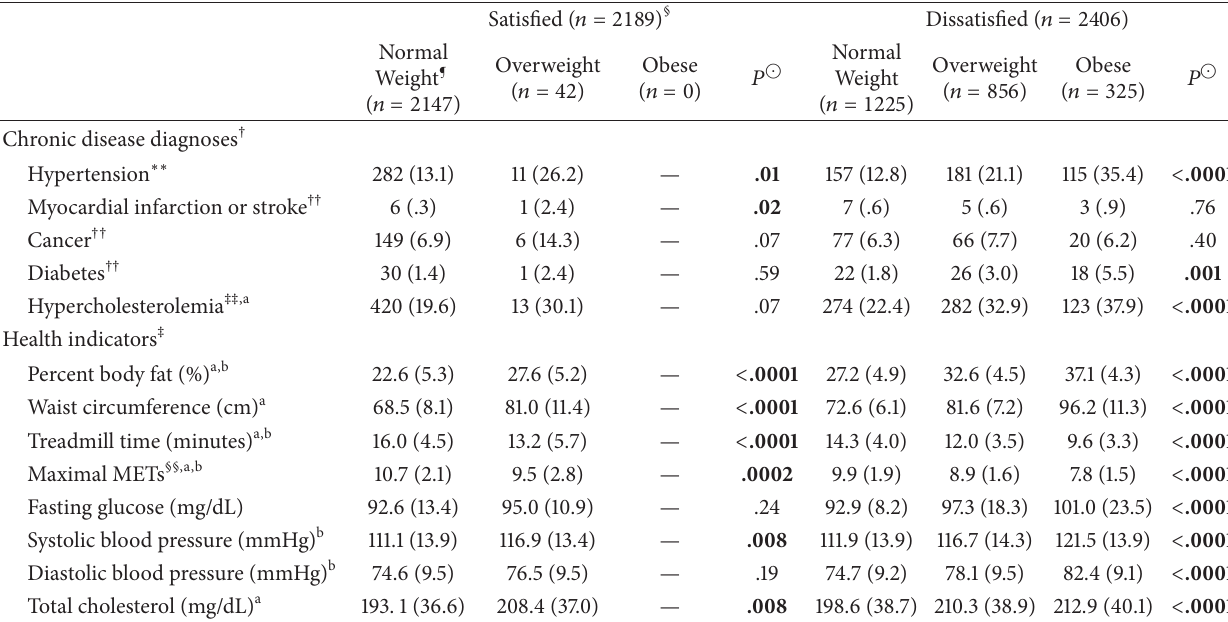
Table 6: Relationships between body weight satisfaction by overweight status and health indicators and history of chronic disease, Aerobics Center Longitudinal Study, 1987–2002: women ( 𝑛 = 4595 ) ∗ .